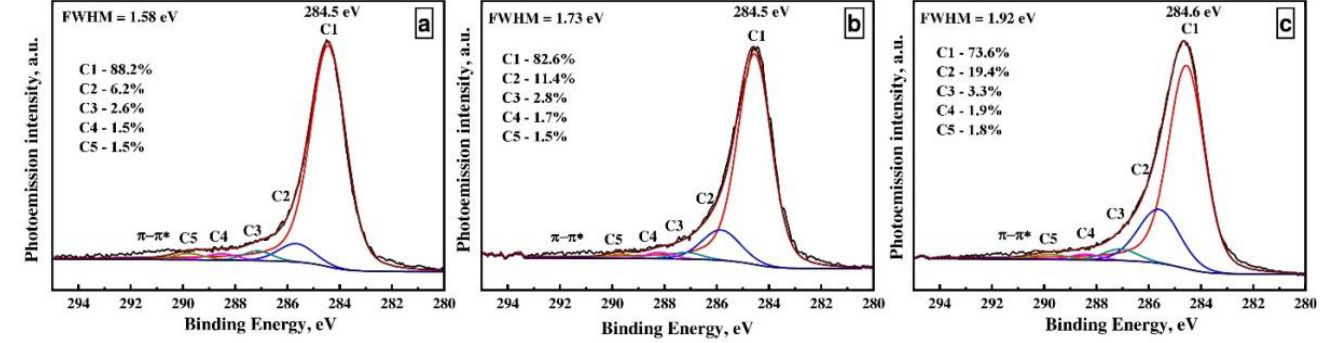
Figure 2. C1s PE spectra of uCNT ( a ), N-CNT ( b ) and N + -CNT ( c ).